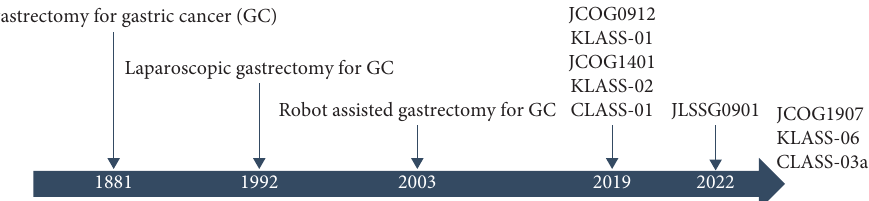
Figure 1: The historical timeline of